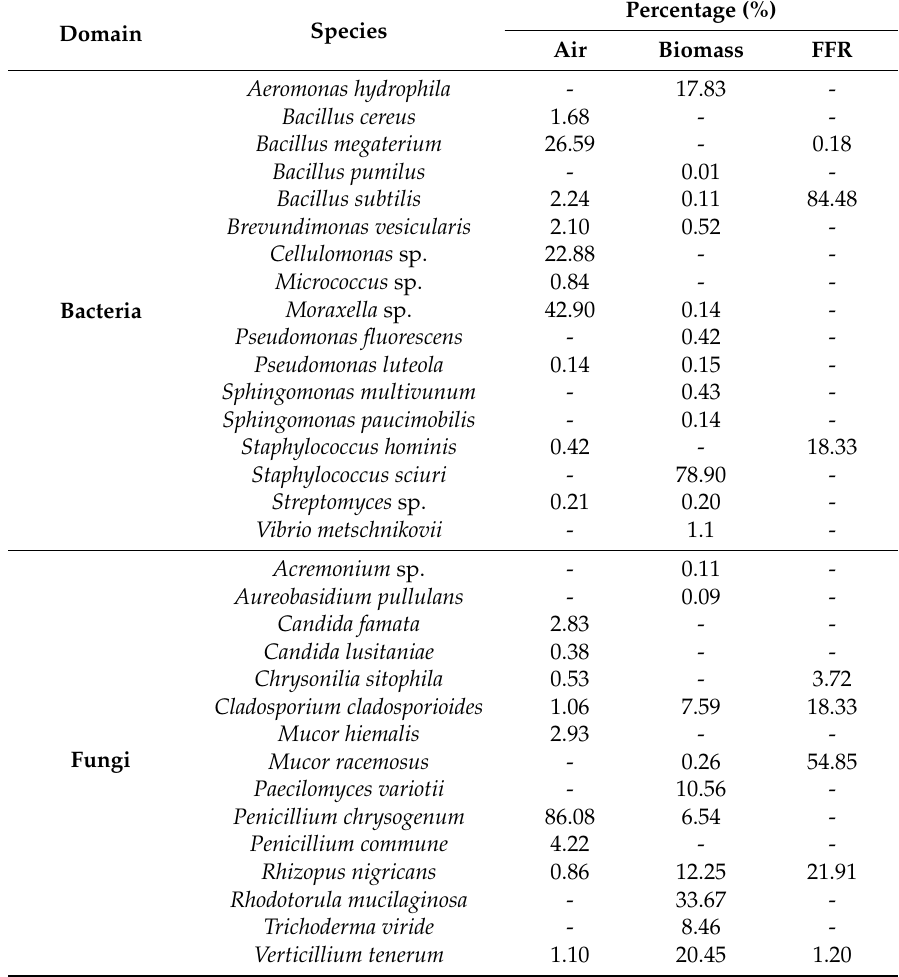
Table 5. Microorganisms isolated from the air, biomass and FFR in cultivation method.